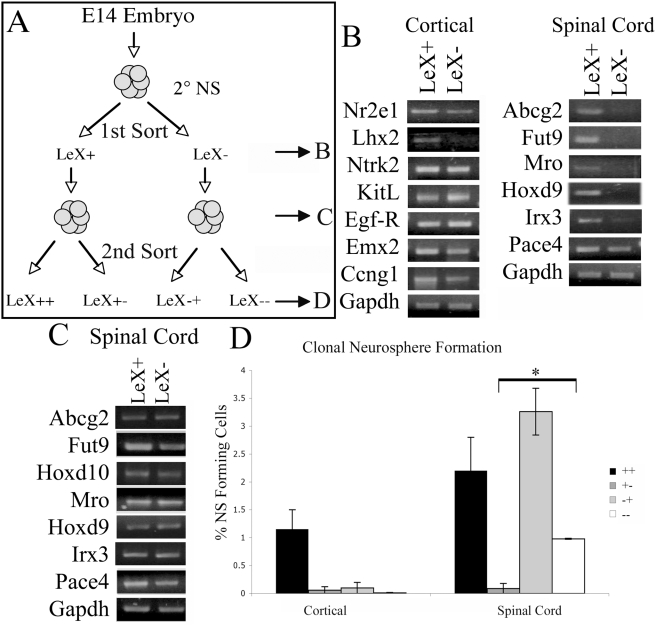
Gene Expression in LeX+ and LeX− cells derived from E14 neurospheres: (A) Schematic of double sorting protocol.B & C refer to stages at which gene expression was analyzed and D refers to clonal neurosphere forming ability of cells after two LeX sorts. (B) RT-PCR of cells immediately following first sort for LeX expression. (C) RT-PCR on neurospheres generated by LeX+ and LeX− spinal cord derived cells. (D) Clonal neurosphere forming ability of cells based on the LeX expression status at two different stages of cell culture (see panel A). First “+” or “−” refers to expression at time of 1st sort and 2nd+/−refers to second sort. * P<0.05, Anova followed by post hoc t-test.